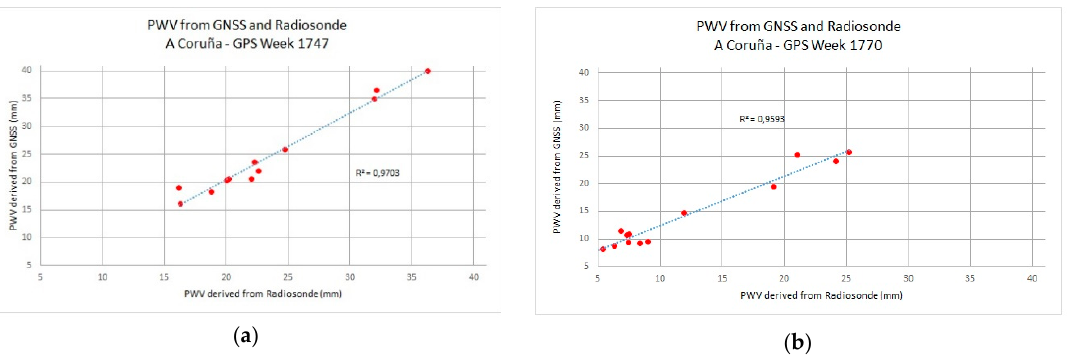
Figure 1. Comparison of PWV. ( a ) Scatter diagram of PWV derived from Radiosonde and GPS on 1747 GPS Week ( b ) Scatter diagram of PWV derived from Radiosonde and GPS on 1770 GPS Week. In both figures, the R2 correlation factor is included. Table 2. Comparisons of the PWV estimated from GNSS and Radiosonde in A Coruña site.